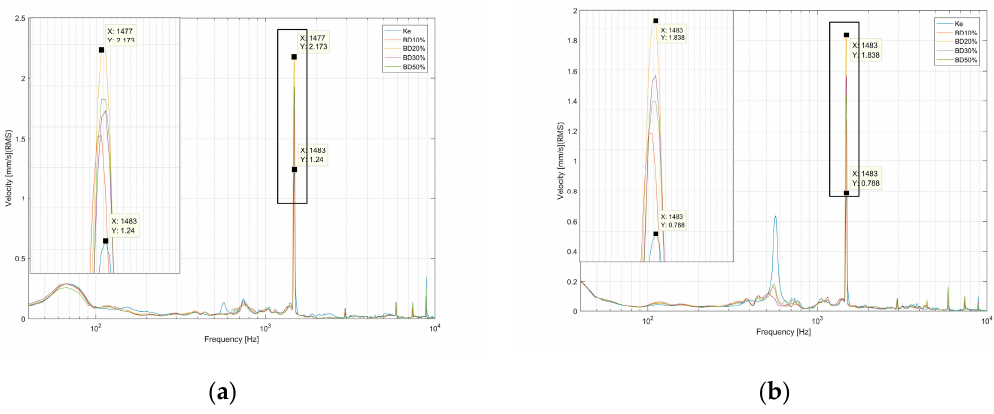
Figure 15. Vibration–FFT time domain analysis for all blends, regime 3 (( a ) X; ( b ) Y).